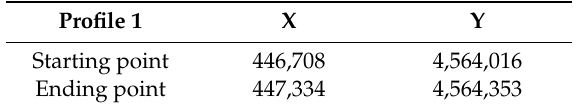
Table 3. UTM coordinates (time zone 30T) of each TDEM made in the area considered in this research.